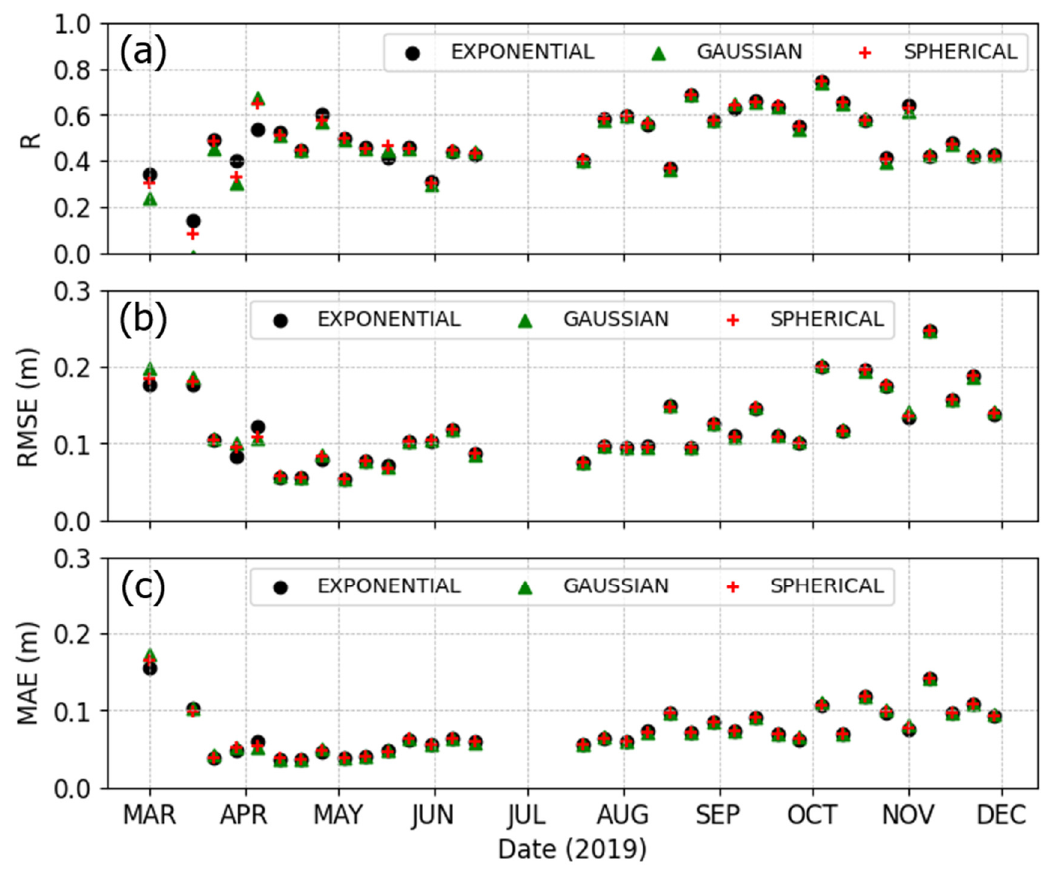
Figure 5. Temporal variations of cross validation parameters: ( a ) correlation coefficient (R), ( b ) root mean square error (RMSE), and ( c ) mean absolute error (MAE).